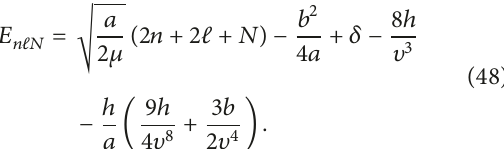
Figure 3: The current potential of 𝐷 meson for different